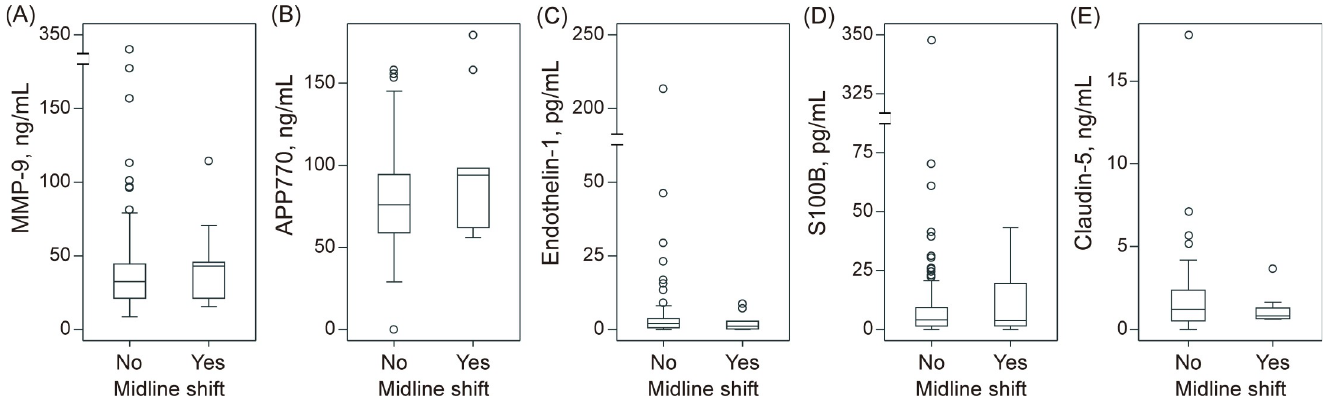
Fig 3. Association between brain edema and biomarkers. APP770 levels were marginally higher in patients with a midline shift � 5 mm than in those without (79 ± 29 vs. 97 ± 41 ng/mL, P = 0.084). APP for amyloid precursor protein; MMP-9, matrix metalloproteinase-9.